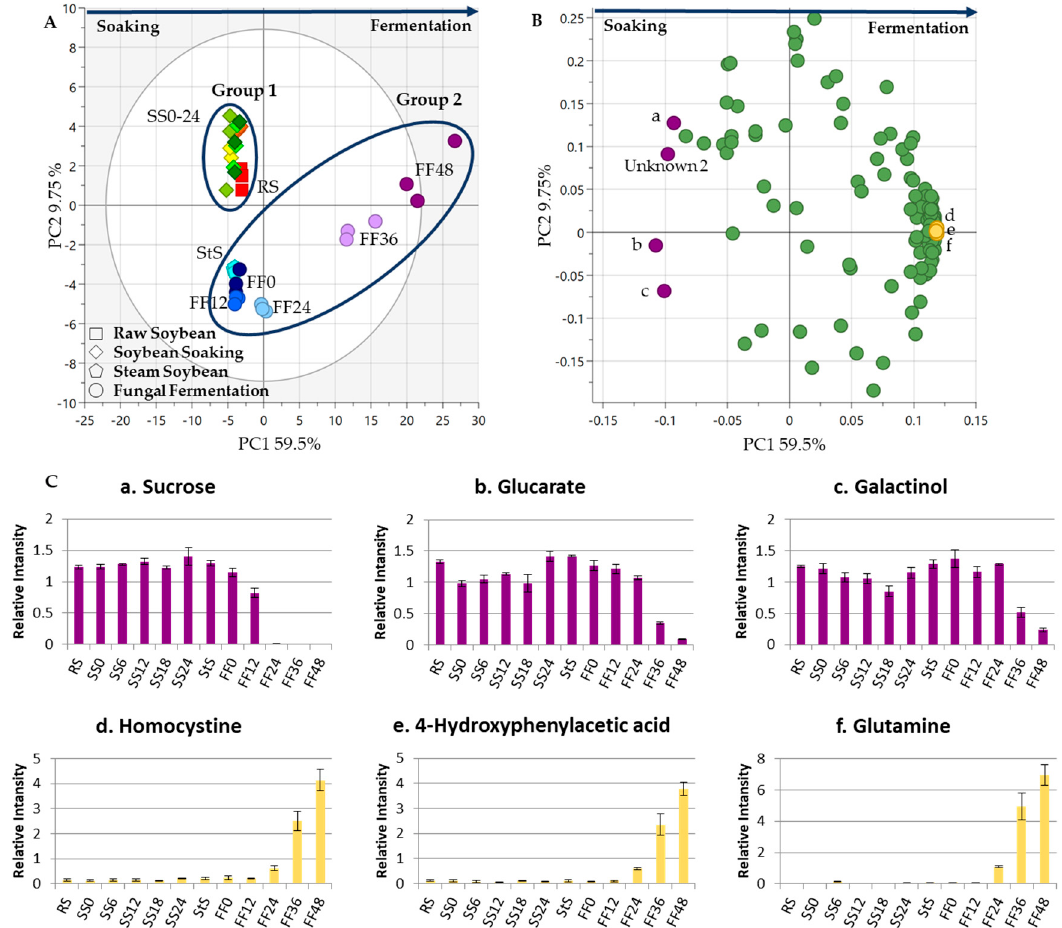
Figure 4. Metabolite changes during the whole tempe production process. The PCA results of eight soybean samples from different sampling times were obtained to observe the metabolite profiles from tempe production process (from RS to FF). ( A ) The score plot shows the separation between each sample based on sampling time. All the soybean soaking (SS) include RS and fungal fermentation (FF) samples were clustered separately into two groups. The points indicate the treatment times, different shapes represent different treatments (RS: raw soybeans, SS: soaked soybeans, StS: steamed soybeans, FF: fungal fermentation), and the numbers indicate the sampling times in hours (0 h, 6 h, 12 h, 18 h, 24 h, 36 h, and 48 h). ( B ) Loading plot. The metabolites are markers from the FF treatment and are labeled as follows: (a) sucrose; (b) glucarate; (c) galactinol; (d) homocysteine; (e) 4-hydroxyphenylaceticic acid; (f) glutamine. ( C ) Bar charts. The metabolites shown in the bar chart are markers from the SS and FF processes. The vertical axis represents relative intensity. The horizontal axis represents the samples. The error bar shows the standard deviation obtained from three replicates.